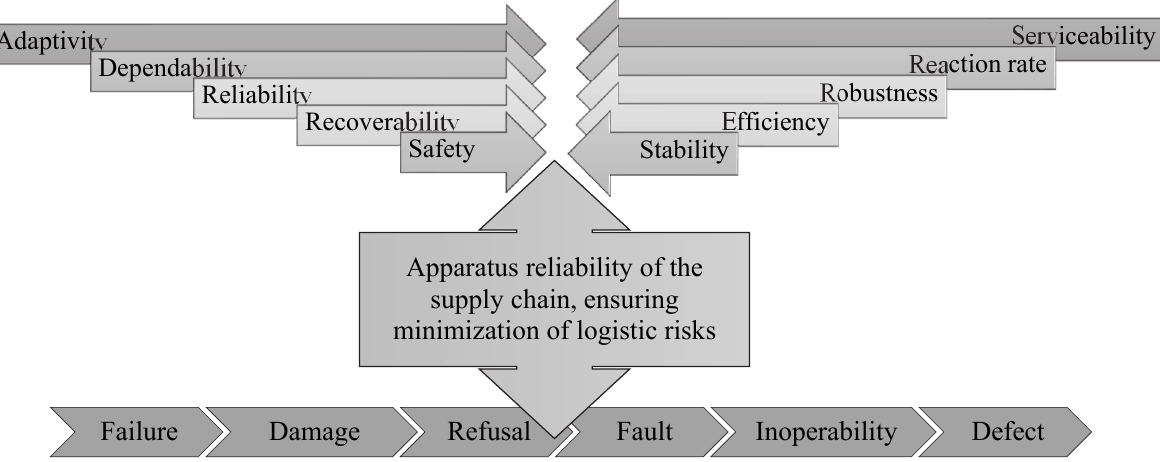
Fig. 3 . Logistic representation of the apparatus of the business process “management